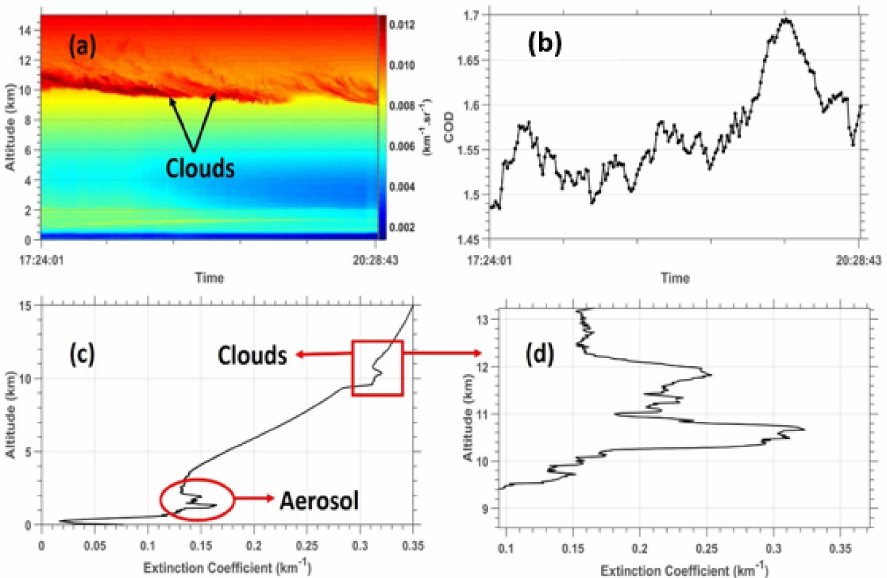
Figure 4. Height-time of total backscatter coefficients ( a ), time evolution of cloud optical depth (COD) ( b ), and extinction coefficient vs. altitude ( c , d ) for 11 April